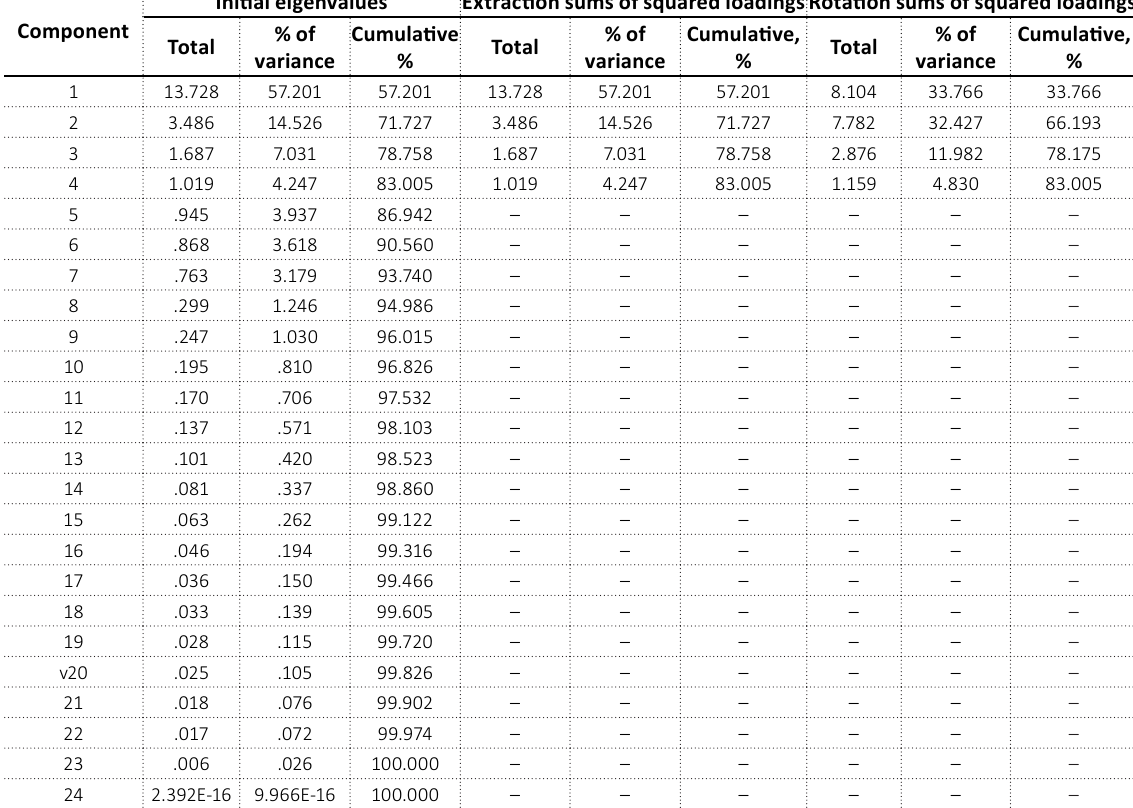
Table 6. Total variance explained